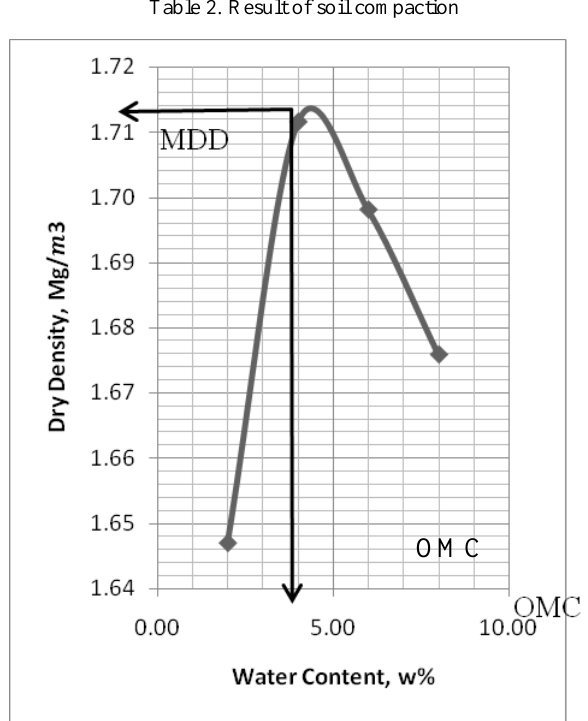
Table 2 . Result of soil compaction